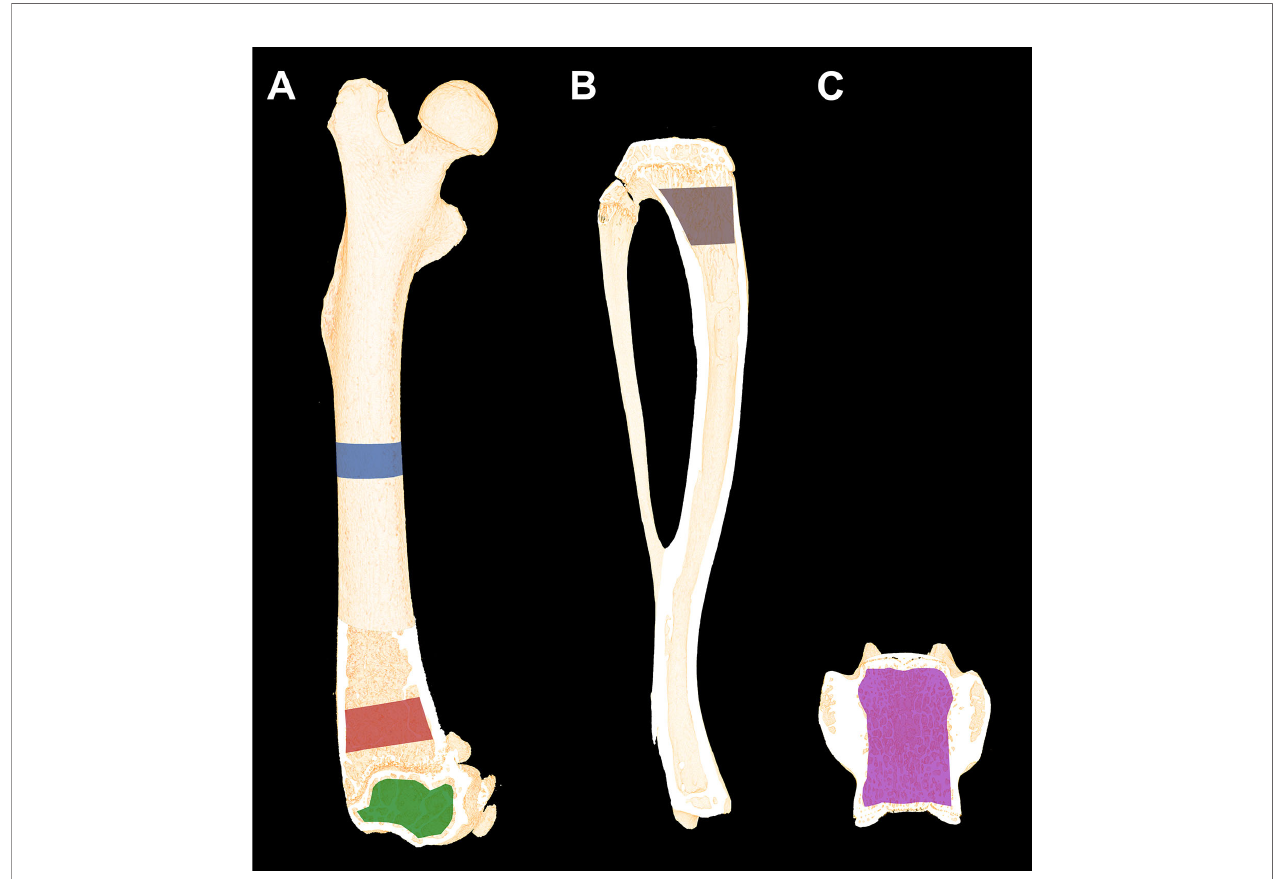
FIGURE 2 | (A) Schematic illustration of the volumes of interest (VOIs) scanned with m CT. Blue: Femoral mid-diaphyseal VOI. Red: Distal femoral metaphyseal VOI. Green: Distal femoral epiphyseal VOI. (B) Region of interest (ROI) of the proximal tibial metaphysis analyzed using dynamic bone histomorphometry and bone cell counting. Dynamic bone histomorphometry was also performed at the femoral mid-diaphysis. (C) The VOI used to analyze L5. Dimensions are not to